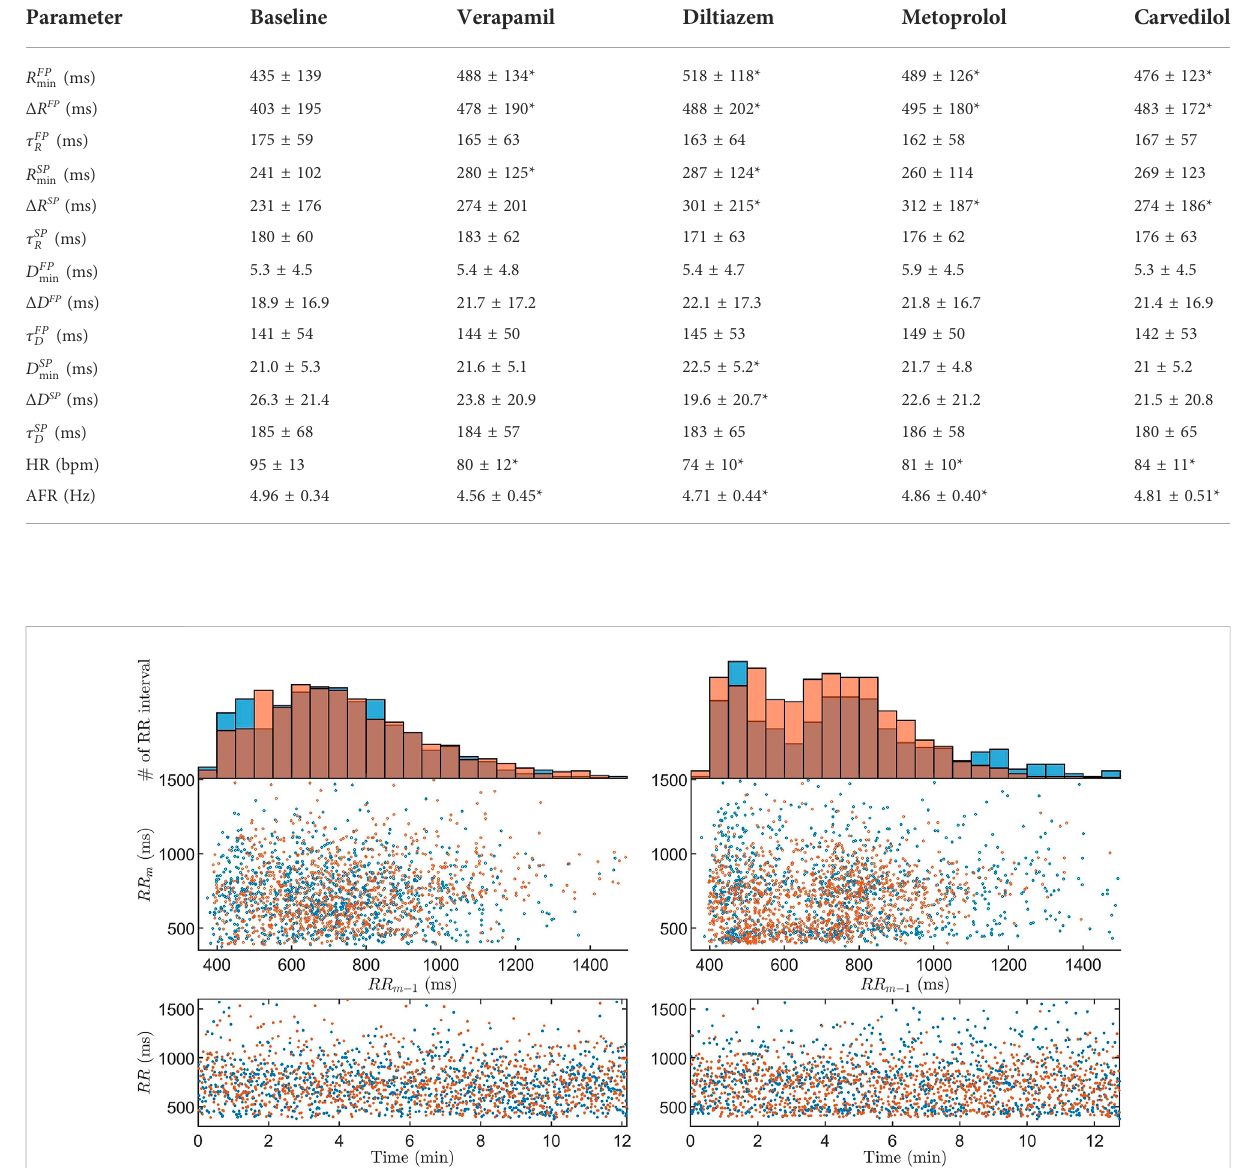
TABLE 3 Recording averages of estimated model parameters, AFR, and HR at baseline and during treatment with the four different drugs (mean ± standard deviation). Differences from baseline are evaluated using the Wilcoxon signed rank test with the Benjamini – Hochberg correction; signi fi cant difference from baseline for the drugs, with false discovery rate at 0.05, is indicated with